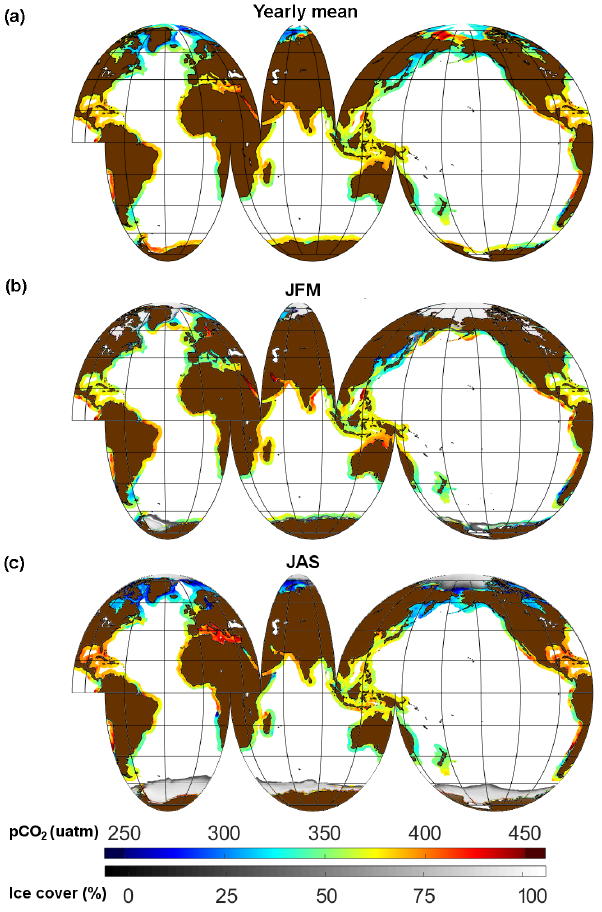
Figure 4. Climatological mean p CO 2 for (a) the long-term av- eraged p CO 2 (rainbow color scale) and sea-ice coverage (black– white color scale). The long-term average p CO 2 corresponds to roughly the nominal year 2006, as the average was formed over the full analysis period from 1998 to 2015: (b) the months of Jan- uary, February and March; and (c) the months of July, August and September.